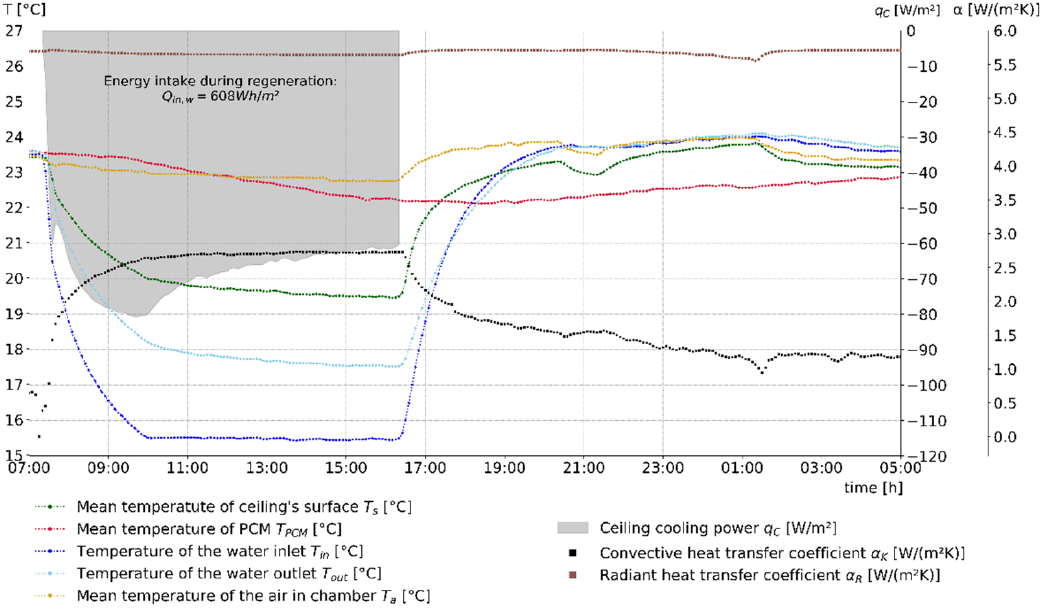
Figure 9. Experimental results for variant IIb.